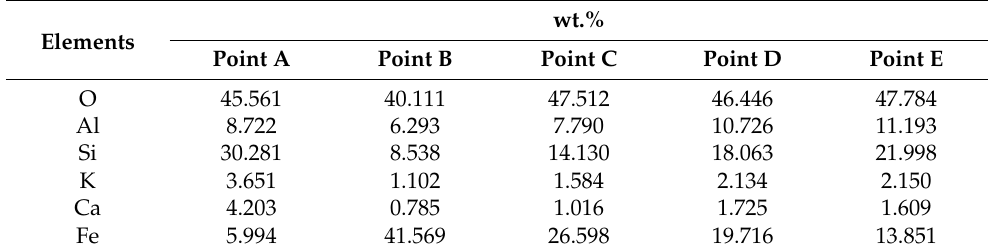
Table 2. Element content of different points (A, B, C, D, and E, shown in Figure 6) in glaze surface. Elements